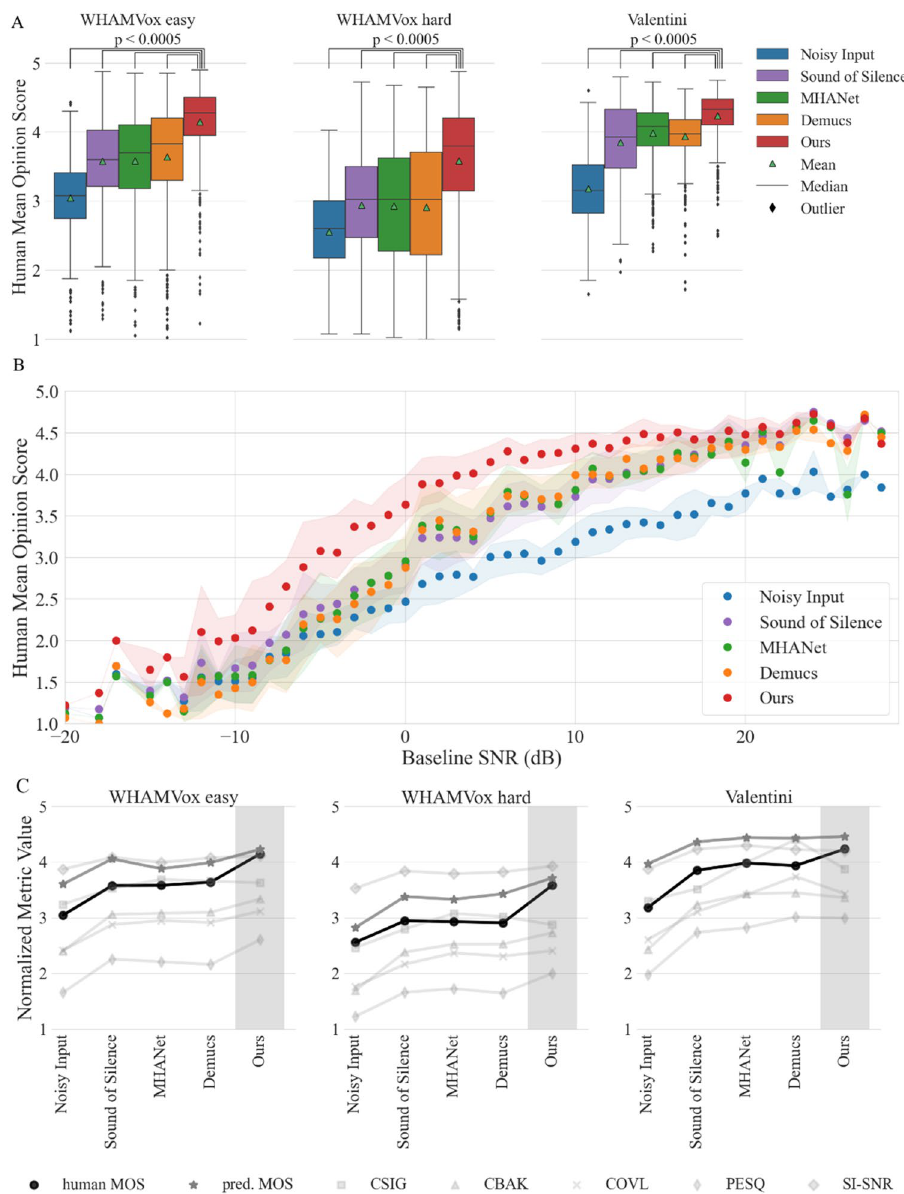
Figure 2. Human mean opinion scores (MOS) of state-of-the-art denoising methods. ( A ) Comparison between current denoising models on 3 publicly available test sets 34 , total of 150,000 Human MOS (500 sound files per dataset, 20 human raters per file, 5 models). Triangles denote the mean, the bar chart shows the 25%, 50% and 75% quartiles, and Whiskers show the 1.5 times the interquartile range. ( B ) Dependence of Human MOS on signal-to-noise ratio (1500 samples of A ). Shading: 25th and 75th quartiles, no shading for SNR values with too few audio samples. SNR values rounded to the nearest integer value. ( C ) Comparison of denoising methods using other common speech quality metrics on a 1 to 5 scale and the SI-SNR, normalized to 1–5 (see Extended Data Fig. S3 for original range and full details on